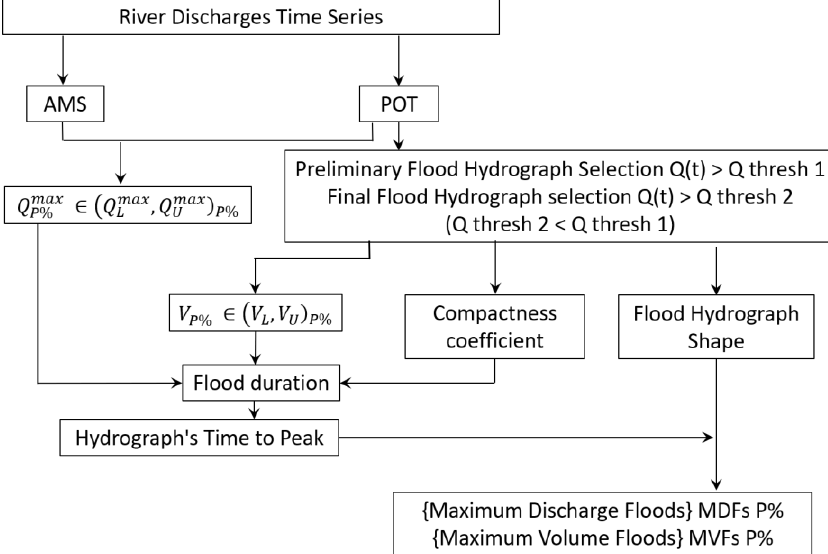
Figure 6. Main stages of the proposed approach for deriving the design flood hydrographs. An ensemble of design flood hydrographs is presented in Figure 7.